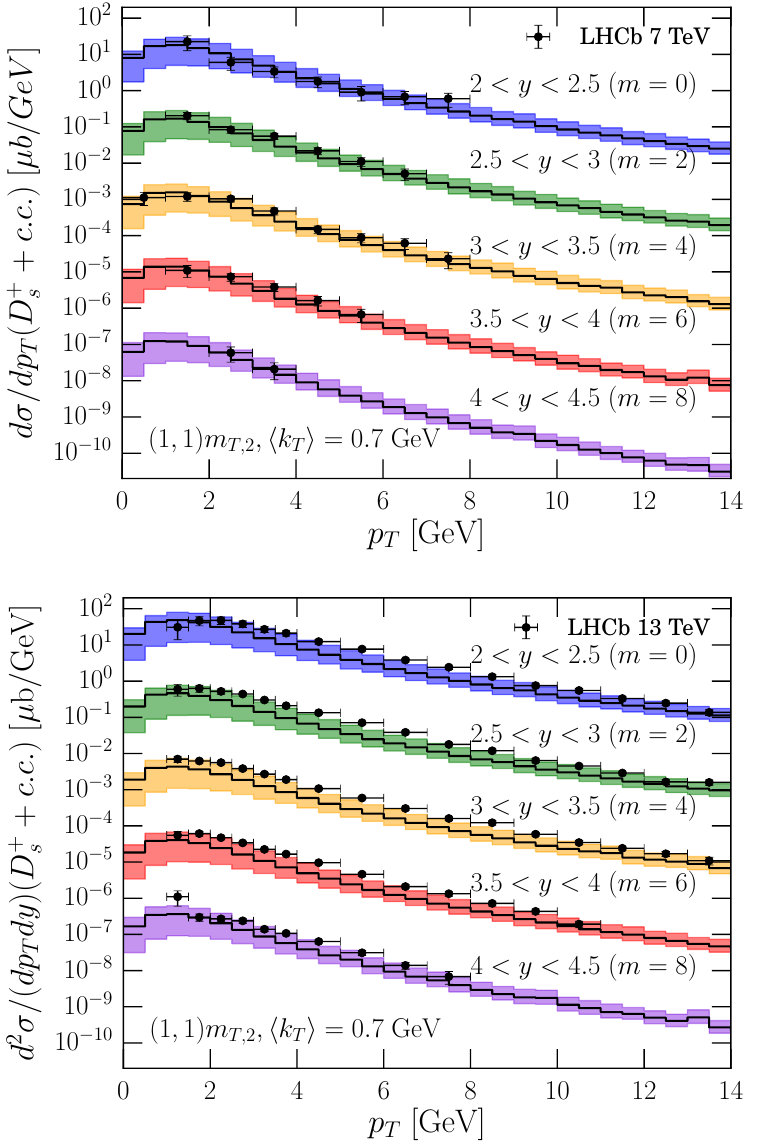
Figure 4. The transverse momentum distribution in the D ± rapidity ranges indicated in the figure, s for production of D + or its charge-conjugate meson in pp collisions compared with LHCb data for s √ dσ ( D + ) /dp T + dσ ( D − ) /dp T at s = 7 TeV [19] (upper) and for d 2 σ ( D + ) /dp T dy + d 2 σ ( D − ) /dp T dy s s s s at 13 TeV [20] (lower). The ∆ y bins are shifted by 10 − m where m = 0 , 2, 4, 6 and 8. The central scale is set to ( µ R , µ F ) = (1 , 1) m T, 2 in theory predictions and h k T i = 0 . 7 GeV. The colored bands show the 7-point scale variation uncertainty around the solid black histograms for the central